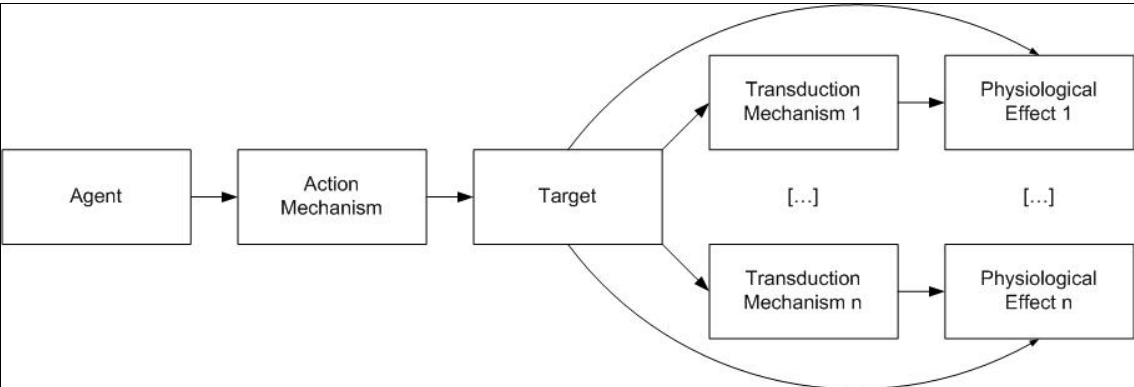
Figure 2: Model for agent-target interactions and their resulting physiological